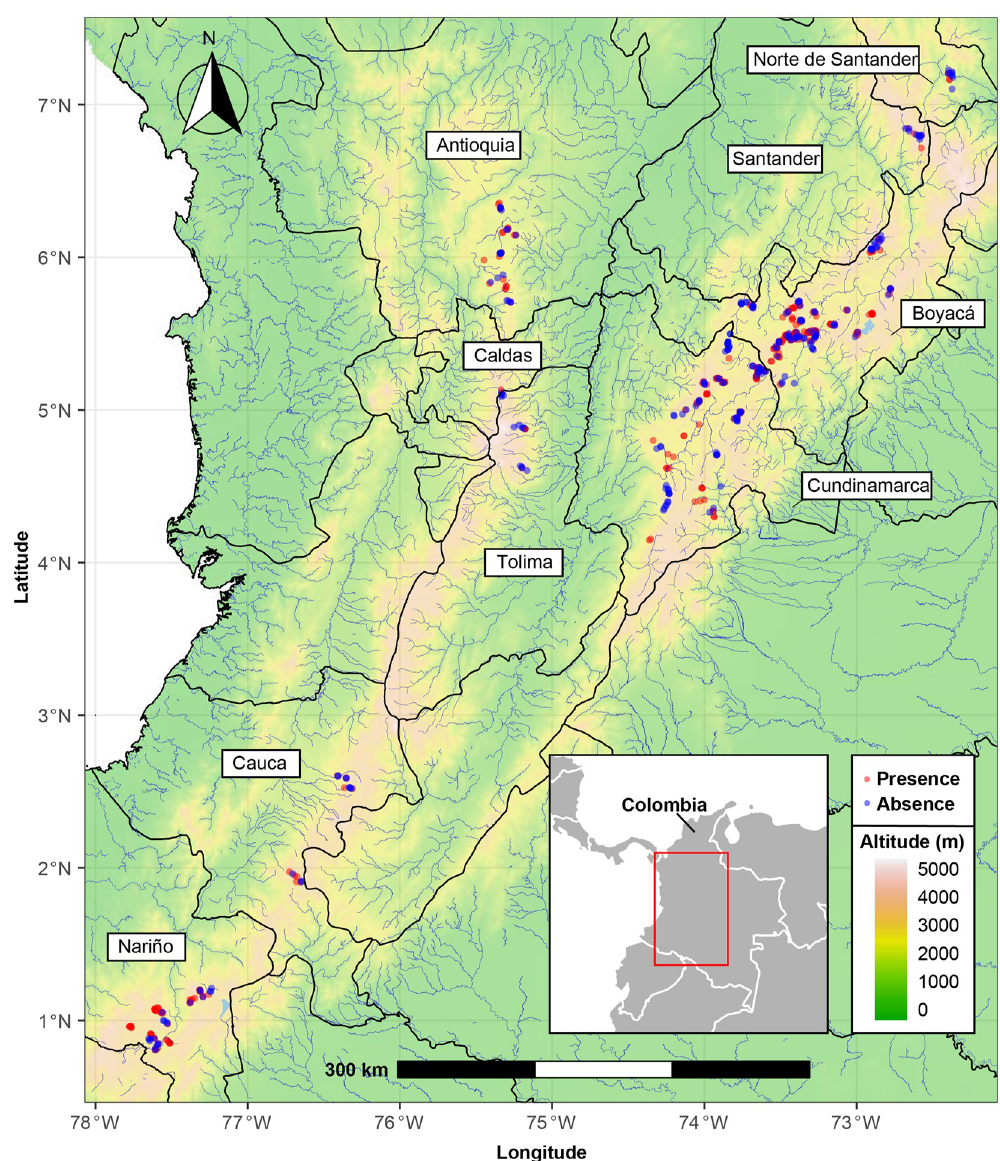
Fig 1. Map of the Colombian Andes showing sampling sites of PCN associated with potato crops in Colombia. Black lines represent department limits, blue lines represent rivers and lakes. Colors according to elevation map. Red dots mark the position of the sample sites that tested positive for PCN and blue dots mark the position of the sampling sites that tested negative for PCN. This figure has been adapted from a base map and data from OpenStreetMap and OpenStreetMap Foundation, original copyright 2020. © OpenStreetMap contributors. Please notice that this figure is similar but not identical to the original image and is therefore for illustrative purposes